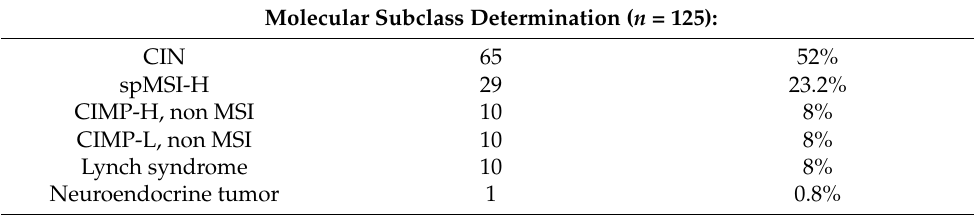
Table 2. Molecular subclasses of the 125 investigated PDX, listed with total amount and percentage. Molecular Subclass Determination ( n = 125):